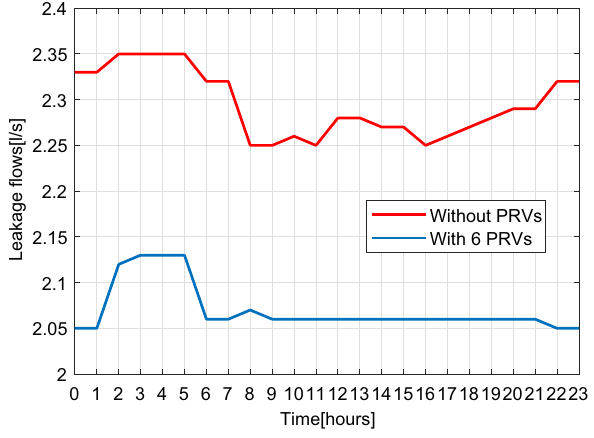
Fig. 7 Water leakage flows for the case 𝛾 =